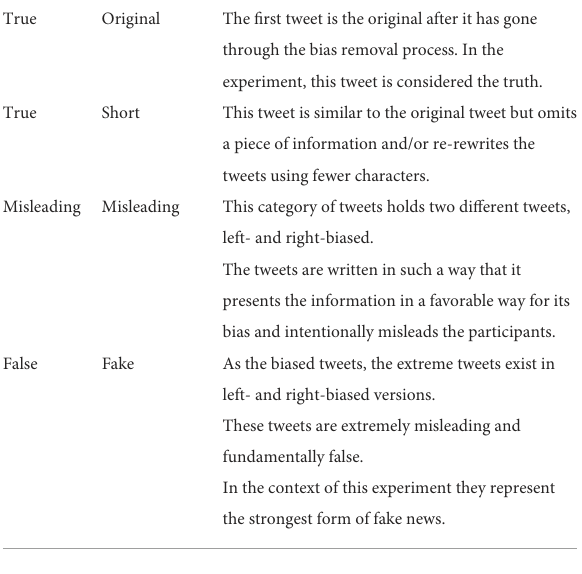
Veracity Tweet type Tweet construction method